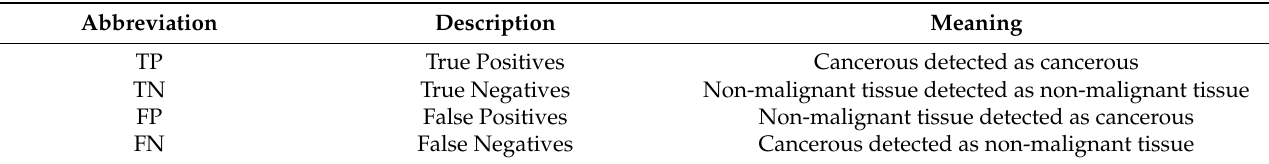
Table 3. Abbreviations that are used in this subsection.